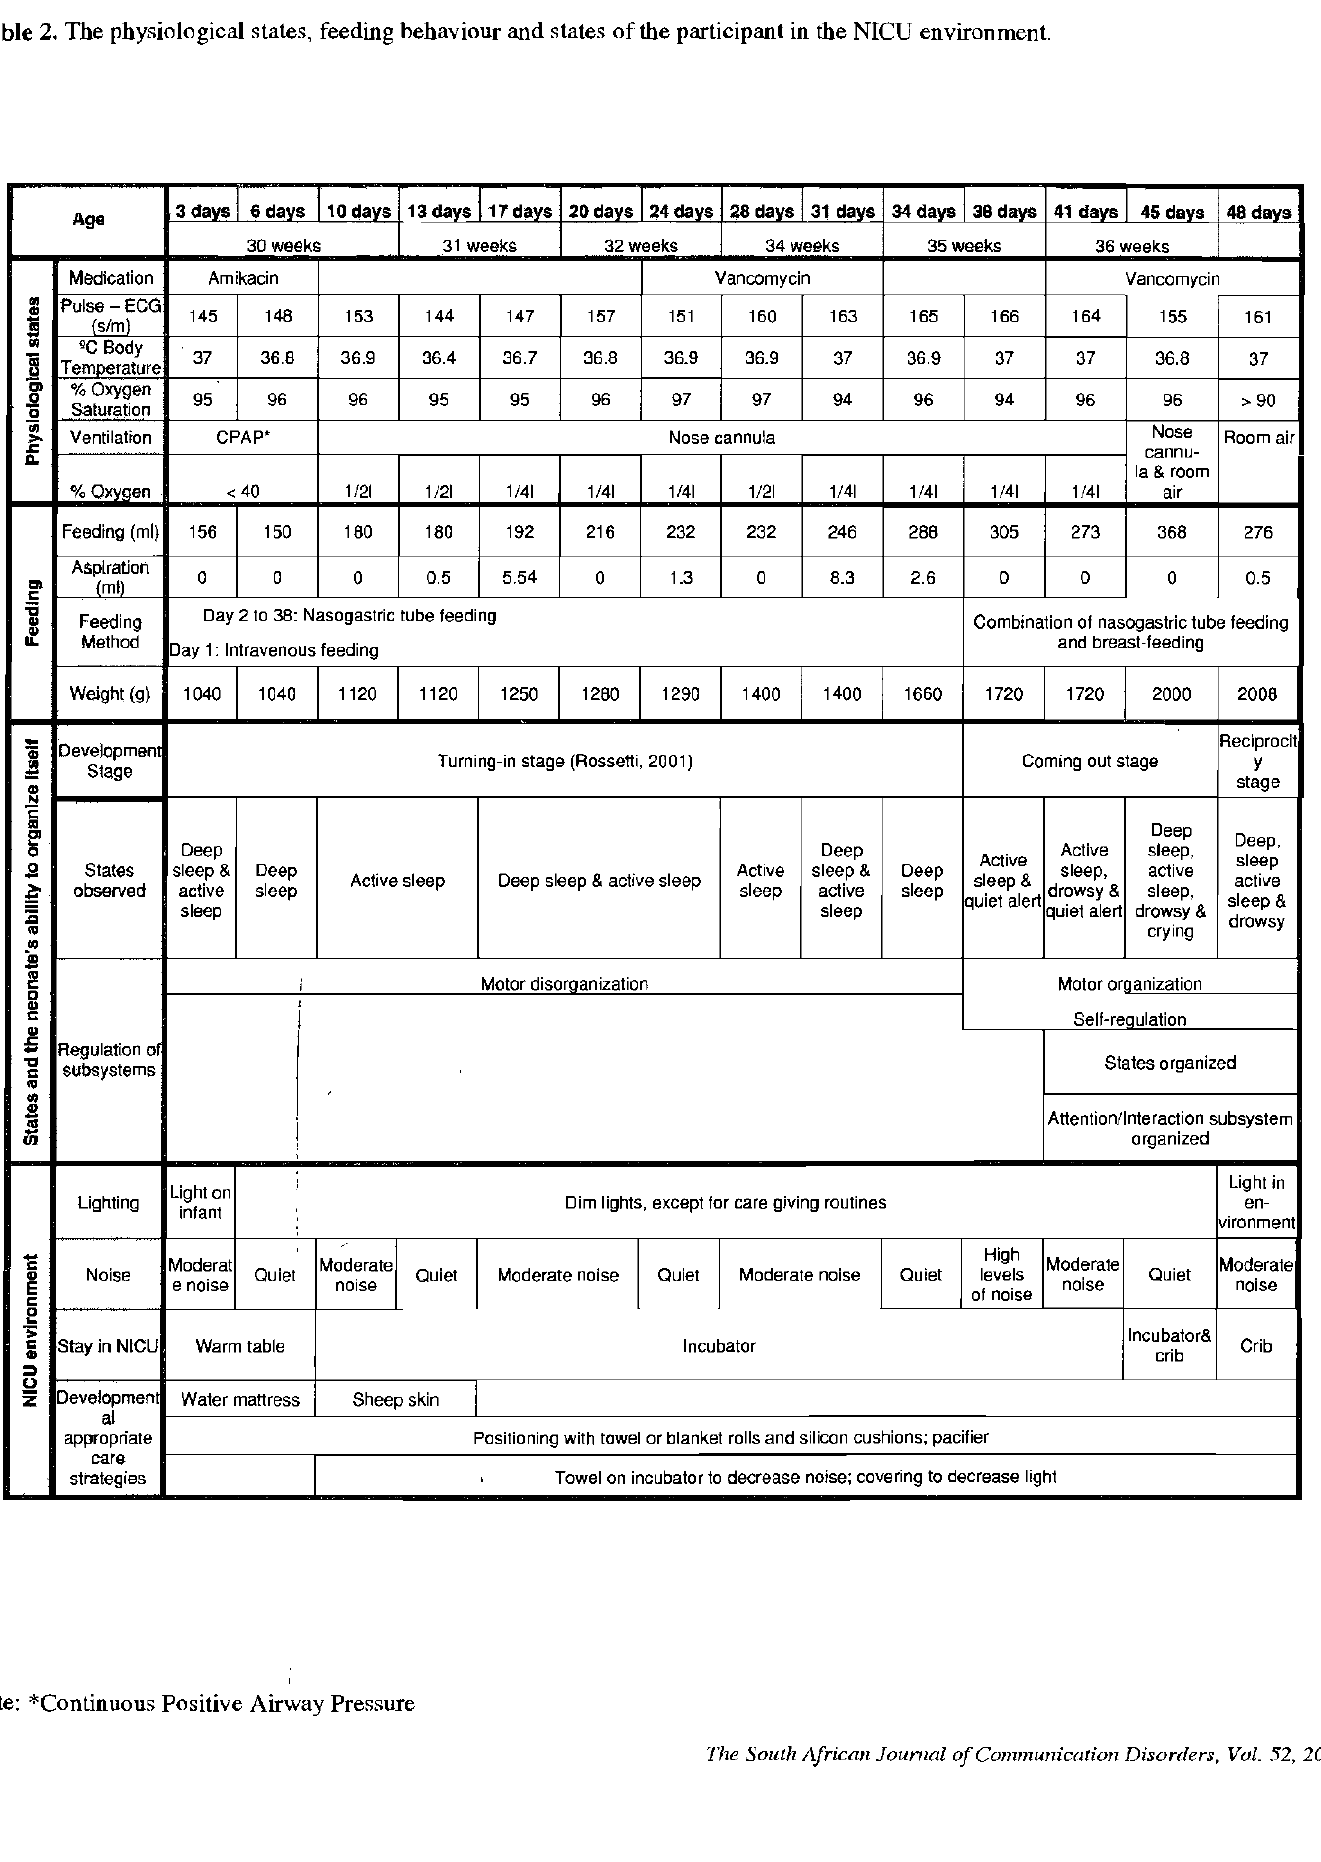
Table 2. The physiological states, feeding behaviour and states of the participant in the NICU